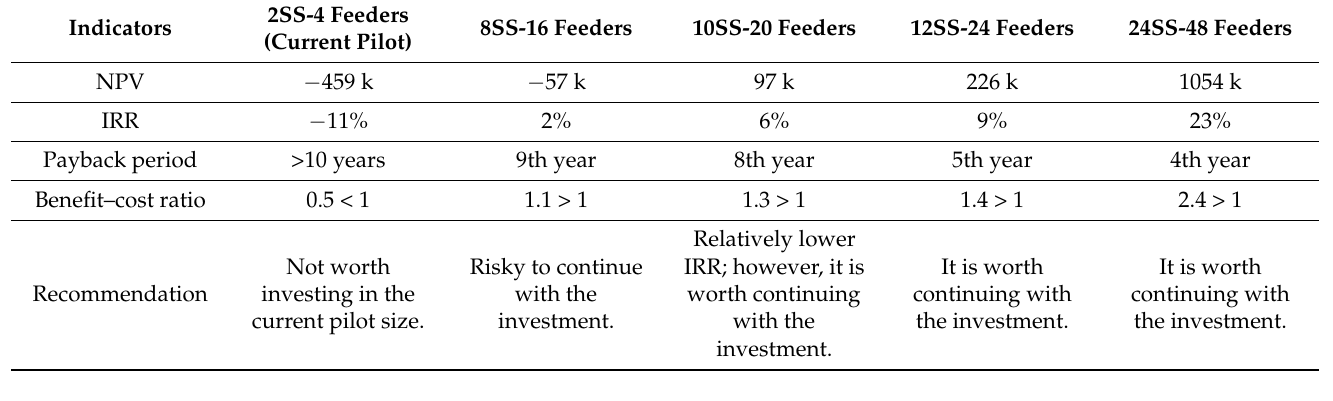
Table 4. Summary of CBA with scale-up of the pilot size.